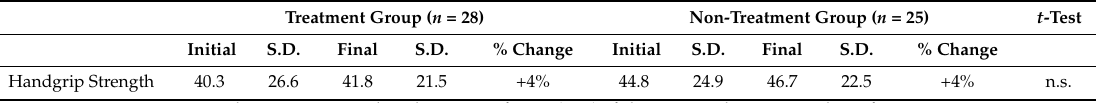
Table 13. Handgrip Strength.